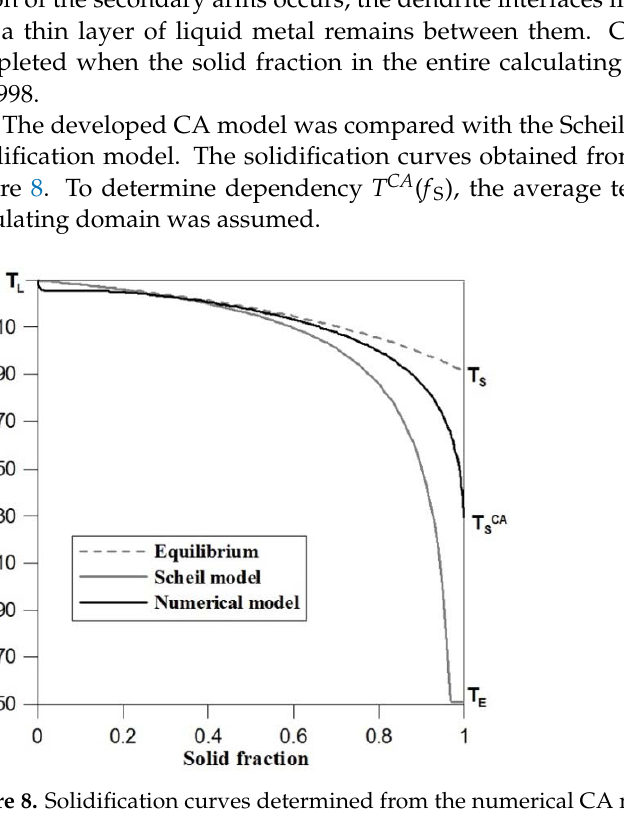
Figure 8. Solidification curves determined from the numerical CA model, equilibrium model and Scheil model.